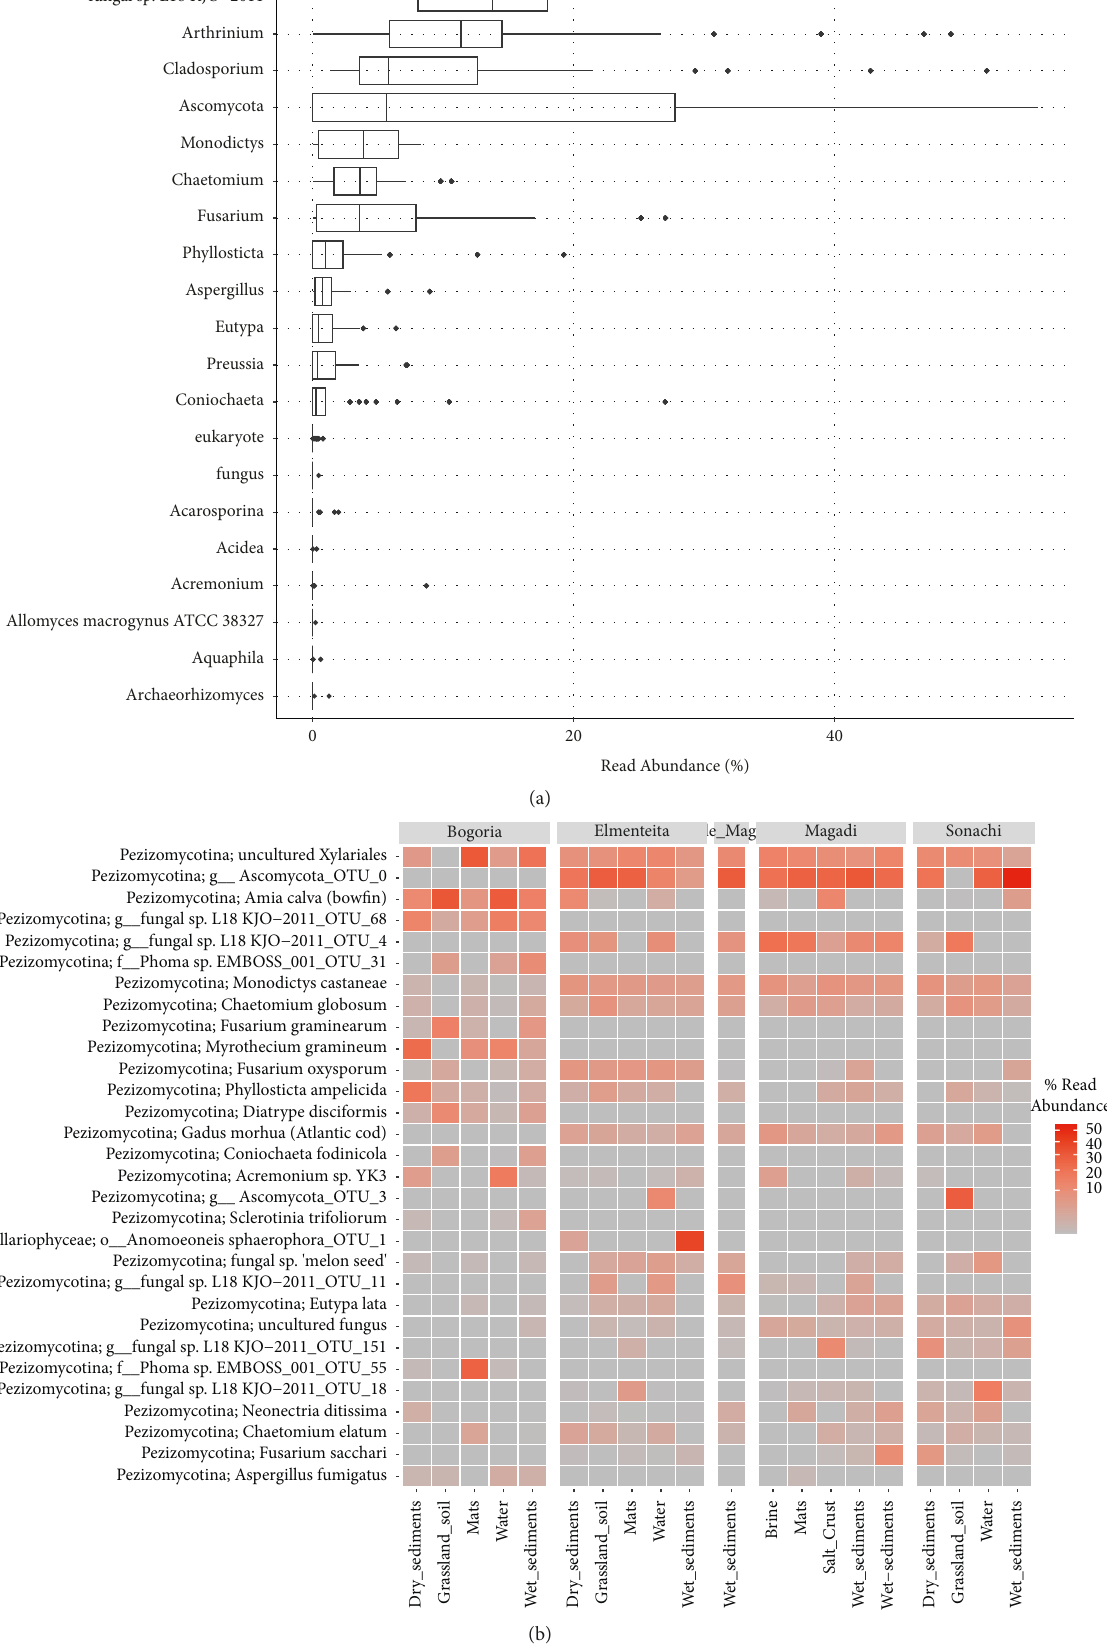
Figure 2: (a) Percentage read abundance of the top 20 species across the samples. (b) Heatmap showing the % abundance of the top 30